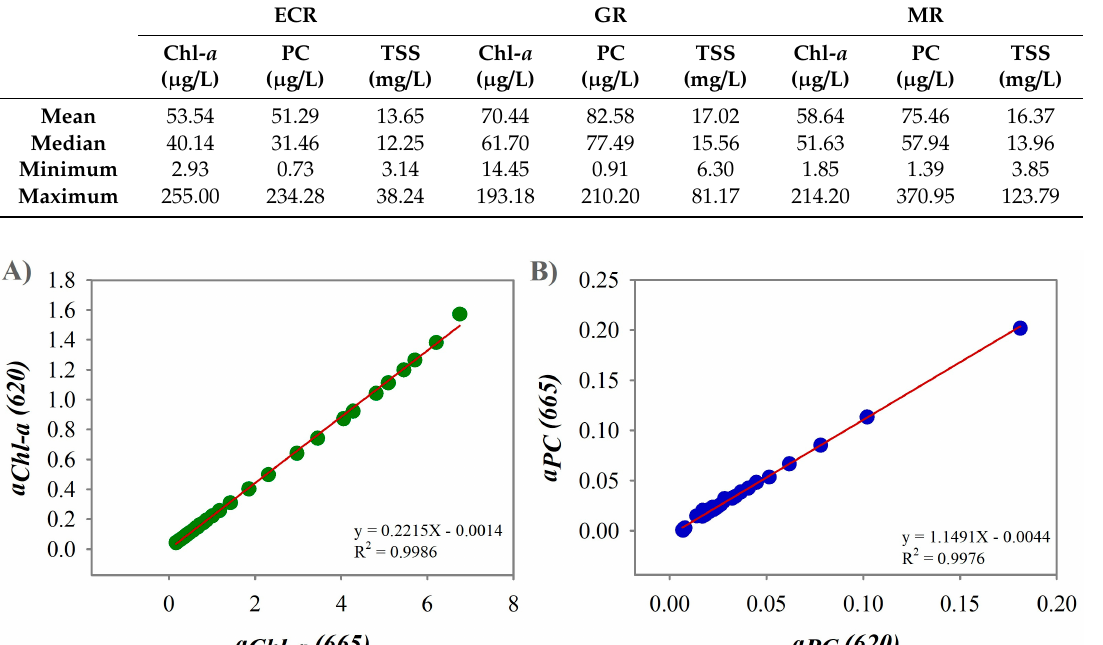
Figure 2. Linear relationships between the absorption coefficients at 620 and 665 nm measured for Sigma Aldrich standards: Chl- a ( A ) and PC ( B ).